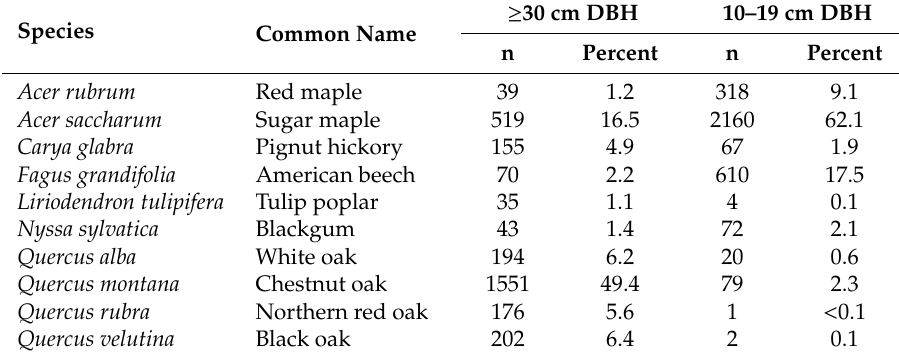
Table 2. Dominant canopy trees ( ≥ 1% of all trees ≥ 30 cm) on Lilly–Dickey Woods forest dynamics plot. Tally and percentages by size class ( ≥ 30 cm diameter at breast height (DBH), n = 3137, and 10–19 cm DBH, n =